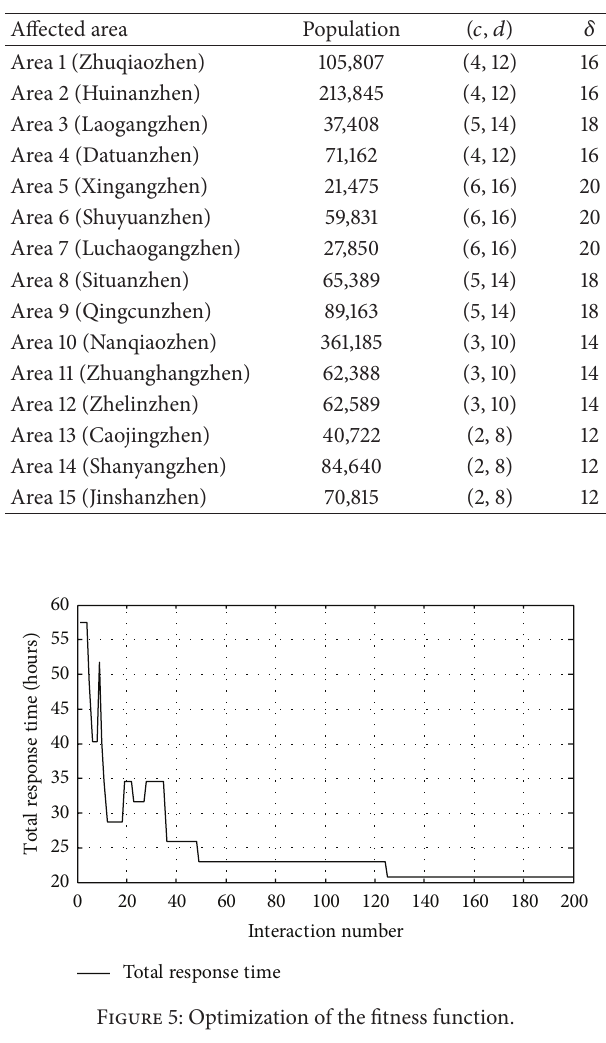
Table 1: Population and demand data of the affected areas.